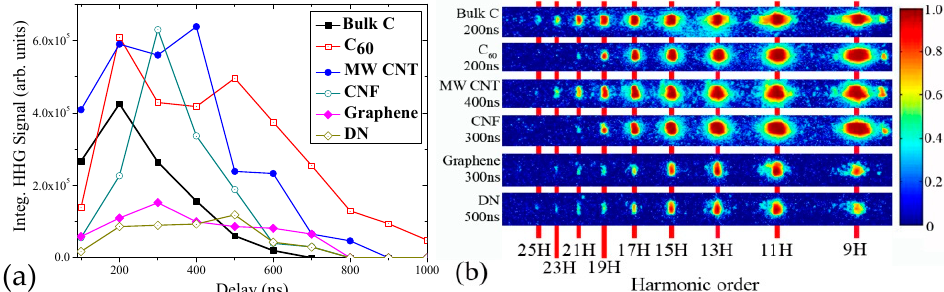
Figure 4. Panel ( a ): dependences of the integrated yield comprising 9th to 25th harmonics on the delay between nanosecond heating pulse (HP) and femtosecond driving pulse (DP). Panel ( b ): raw images of the harmonics at the optimal delay for each plasma sample. Images are normalized and logarithmically scaled. For bulk C, the maximal yield of harmonics is shown at a a delay equal to 200 ns. The optimal delays for C 60 , MW CNT, CNF, Gr, and DN were 200, 400, 300, 300, and 500 ns, respectively.